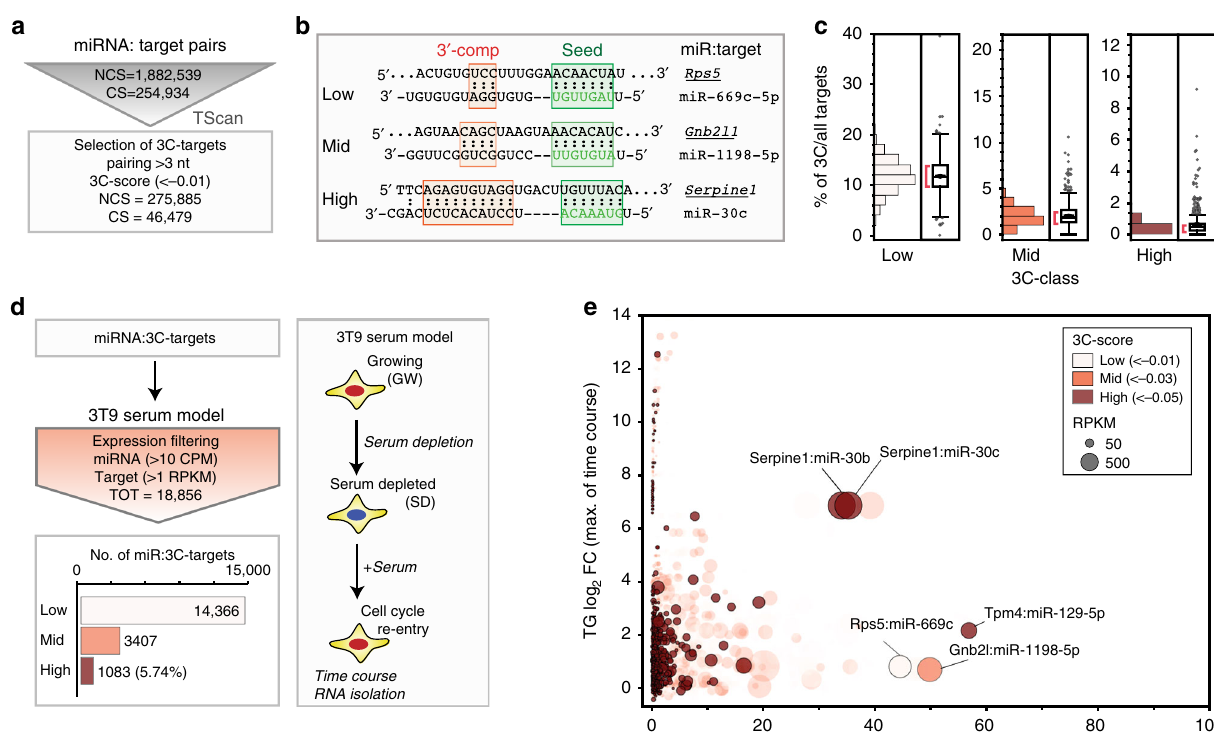
Fig. 1 Candidate TDMD targets in 3T9 fi broblasts. a Scheme summarising fi ltering criteria to select 3C-targets from all miRNA:target pairs present in the TargetScan6.2 database (NCS non-conserved sequence, CS conserved sequence). All 3C-targets were further classi fi ed according to their 3 ′ complementarity score (3C-score). b Three classes of 3C-scores were identi fi ed: low, from – 0.01 to – 0.03; mid, from – 0.03 to – 0.05; and high, lower than – 0.05. Representative examples are shown. c The fraction of 3C-targets over the total number of predicted targets, has been calculated for each miRNA and plotted as distribution, with box-plots and whiskers for each class of targets. d 3C-targets (as in ( a )) were screened to determine which ones were eligible for the 3T9 serum model (schematised on the right). Only the pairs expressed in at least one condition (growing cells, serum depleted cells or time course following serum stimulation) were retained. The distribution of fi ltered pairs based on the 3C-score is also reported. e Bubble plot showing all the fi ltered miRNA:target pairs (from ( d )) strati fi ed according to the target max contribution (percentage; x -axis) to the 3C-targets pool of a miRNA (RPKM target /RPKM Sum_all_3C-targets ) and to the target max regulation (log 2 FC; y -axis) across the entire time course. Bubble size is proportional to target abundance (RPKM target ), and target colour re fl ects the class of